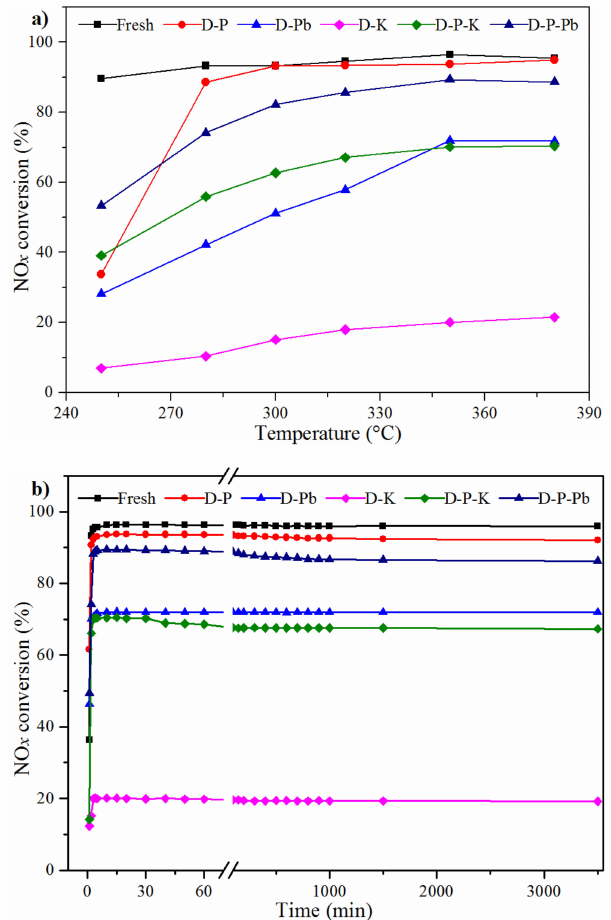
Figure 1. ( a ) NO x conversion of fresh catalyst and poisoned catalyst. ( b ) NO x conversion of fresh catalyst and poisoned catalyst at 350 ◦ C with time. Reaction conditions: [NO] = [NH 3 ] = 500 ppm,